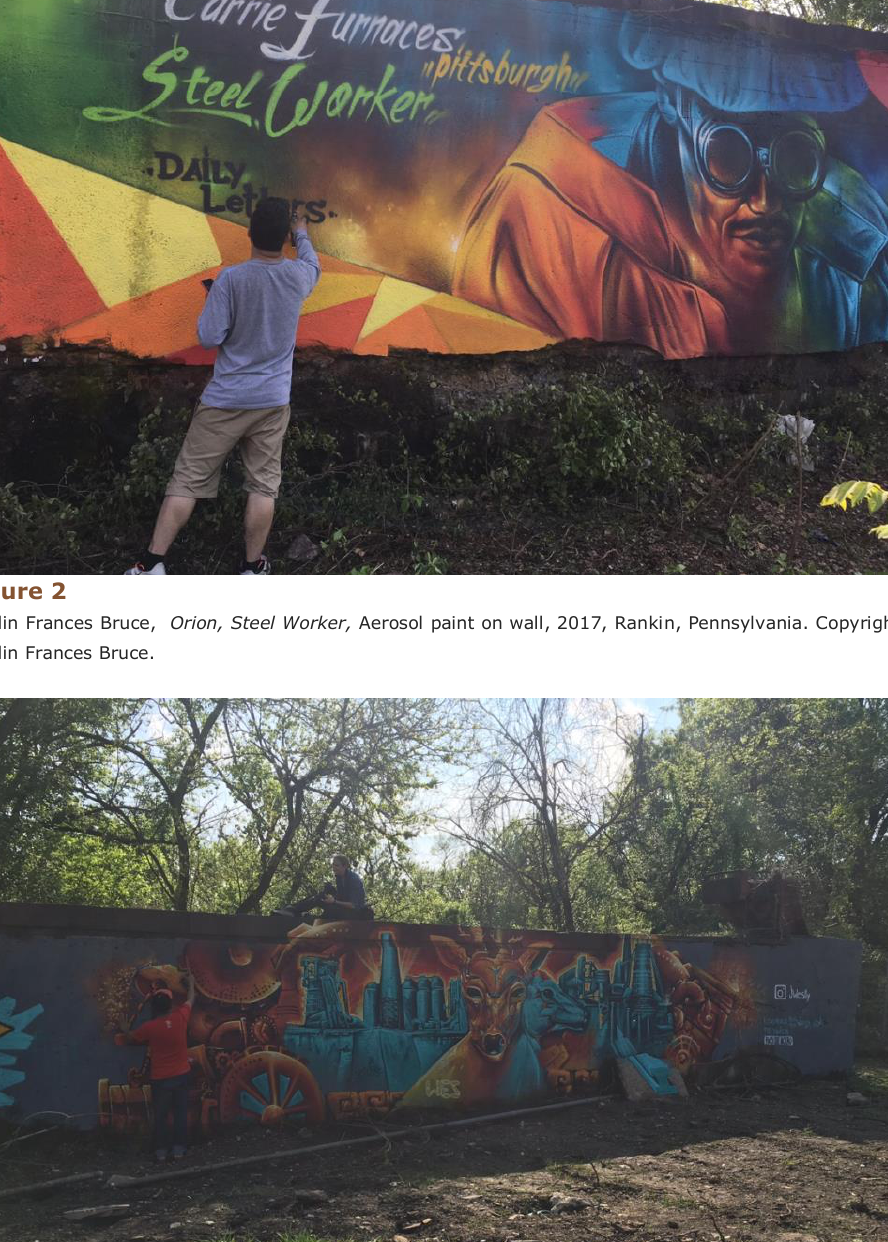
Contemporaneity: Historical Presence in Visual Culture http://contemporaneity.pitt.edu Vol 7, No 1 (2018) | ISSN 2153-5914 (online) | DOI 10.5195/contemp/2018.236